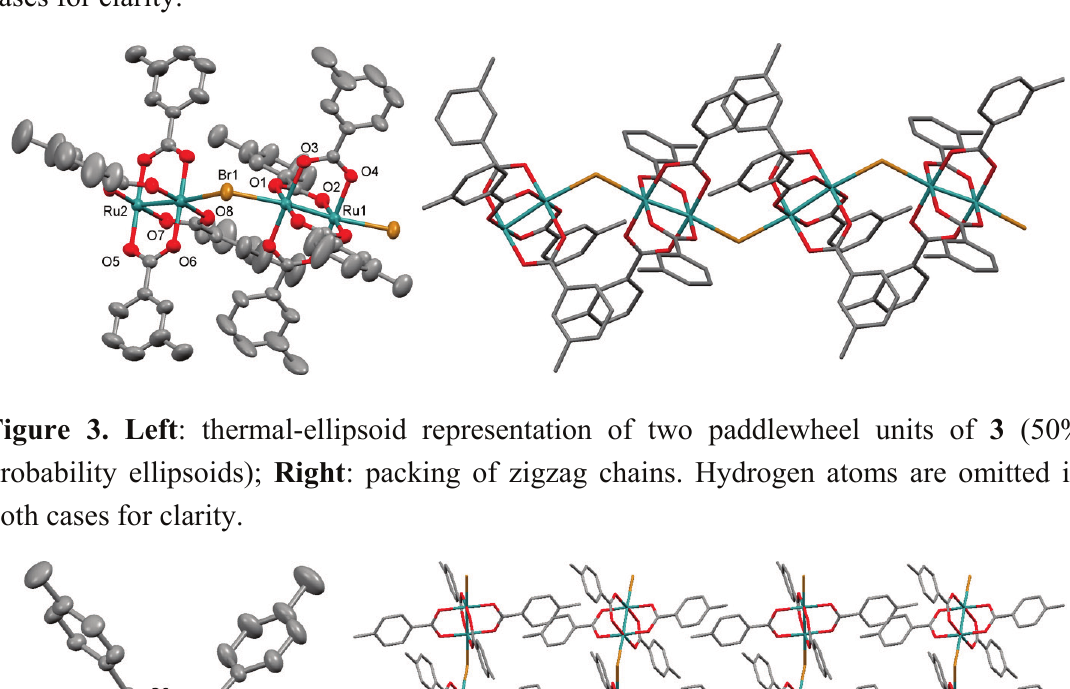
Figure 2. Left : thermal-ellipsoid representation of the one paddlewheel unit of complex 2 (50% probability ellipsoids); Right : zigzag chain. Hydrogen atoms are omitted in both cases for clarity.